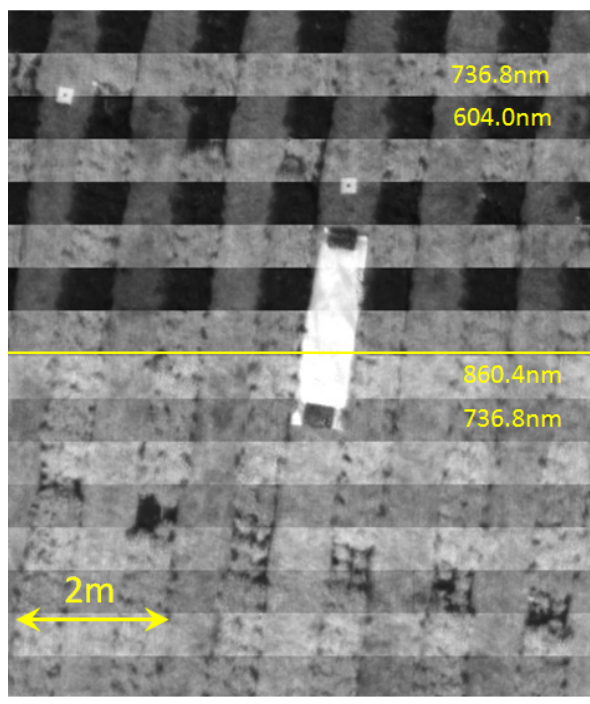
Figure 7. Composite of bands: (top) 1 (604.0nm) and 31 (736.8nm) and bands (bottom) 31 (736.8nm) and 62 (860.4nm). Another interesting way to visually assess how closely the spectral bands are co-registered is to visualize a slice of hypercube including objects with sharp contrast changes. An example of such slice is shown in Figure 8.